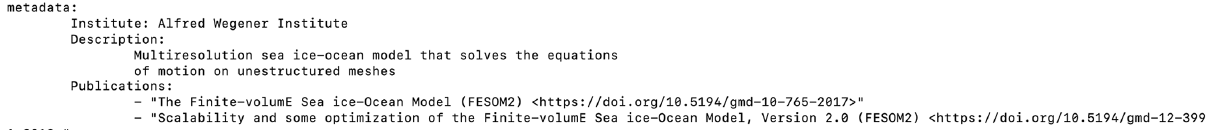
Figure 4. Section of the fesom-1.4 YAML configuration, containing the model metadata used to automatically assemble parts of the ESM- Tools